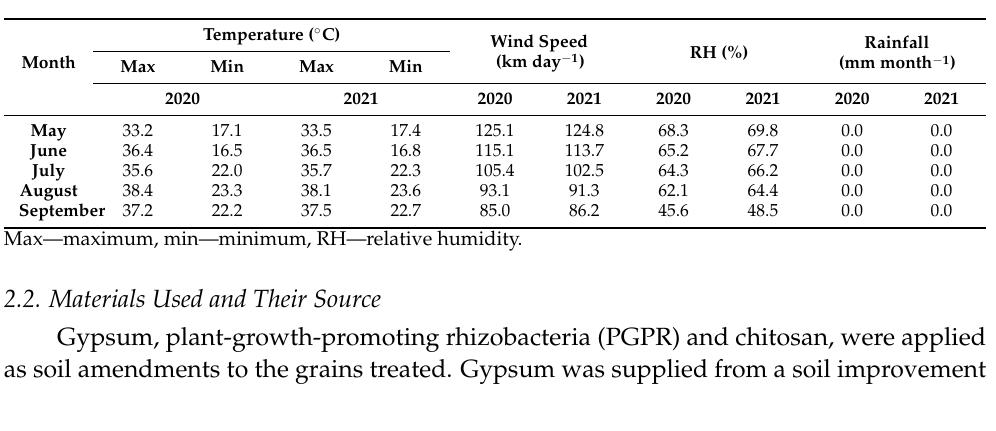
Table 1. Meteorological data for the two summer growing seasons of 2020 and